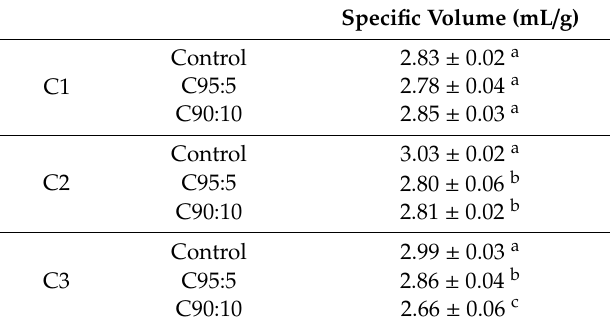
Table 2. The specific volumes (mL / g) of bread loaves with BSG addition and di ff erent types of flours after 24 h.